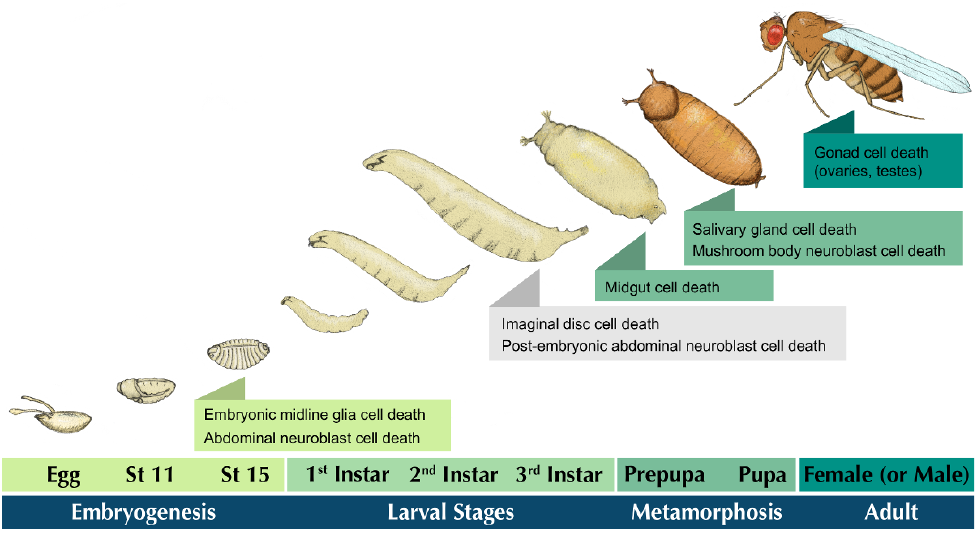
Figure 1. Cell death events during the Drosophila life cycle. An illustration of Drosophila development. A fertilized egg develops through 17 stages of embryogenesis, culminating in the hatching of a 1st instar larva. The larva molts through two additional stages (2nd and 3rd instar), then undergoes metamorphosis. An adult fly emerges from the pupa and searches for a mate to continue the cycle. Forms of cell death discussed in this review are shaded according to the developmental stage in which they occur. Select examples of other cell death events are listed in